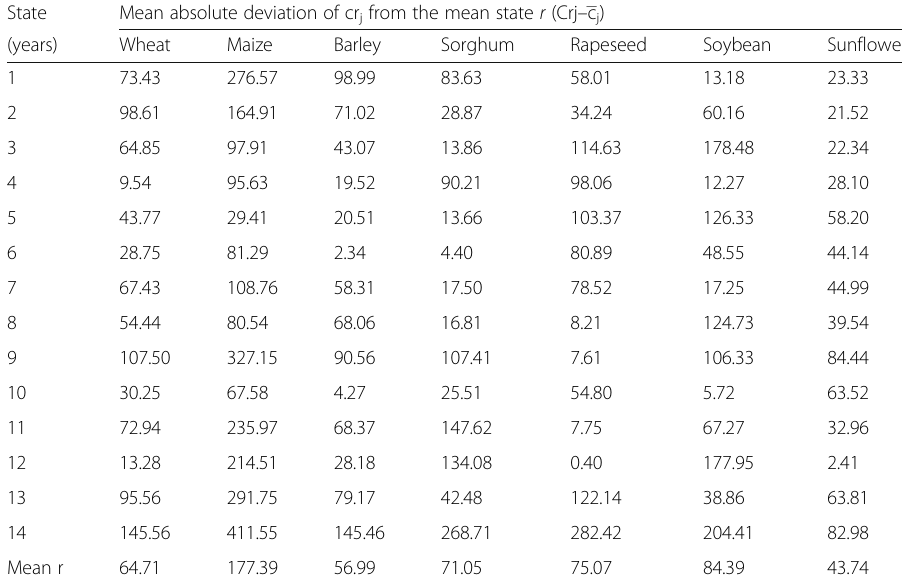
Table 3 Mean absolute deviations of a single observation cr j from mean state r : cr j – c ̅ j (see Table 4)